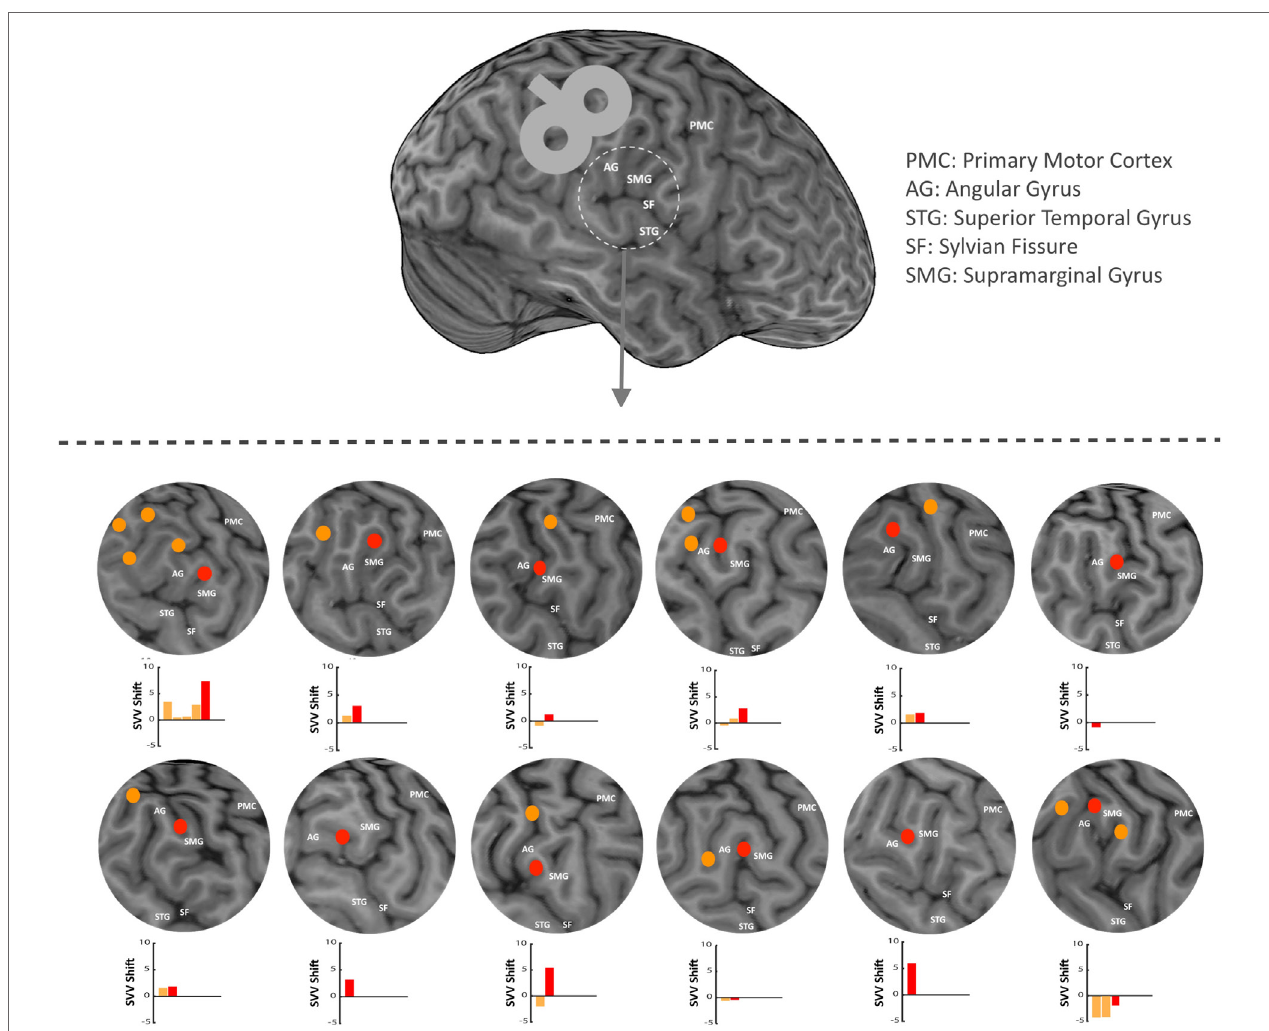
FigUre 2 | In each participant, anatomical landmarks were used on the brain MRI to estimate the location of the supramarginal gyrus (SMGp) within the right temporoparietal junction (TPJ). TMS was applied around the right supramarginal gyrus in order to functionally verify the location of SMGp through the effect of TMS on SVV responses (using real-time neuronavigation). Red dots show SMGp and orange dots show other probed locations within the TPJ. The corresponding SVV shifts are also shown for all locations. Here, the SVV shift is shown as the difference between the averages of post- and pre-TMS values. A positive SVV shift indicates a right shift and a negative SVV shift indicates a left shift. The SVV shift at SMGp (red bar) has a more positive value relative to the other cortical locations (orange bars), which means it is in the opposite direction of the head tilt (i.e., a right